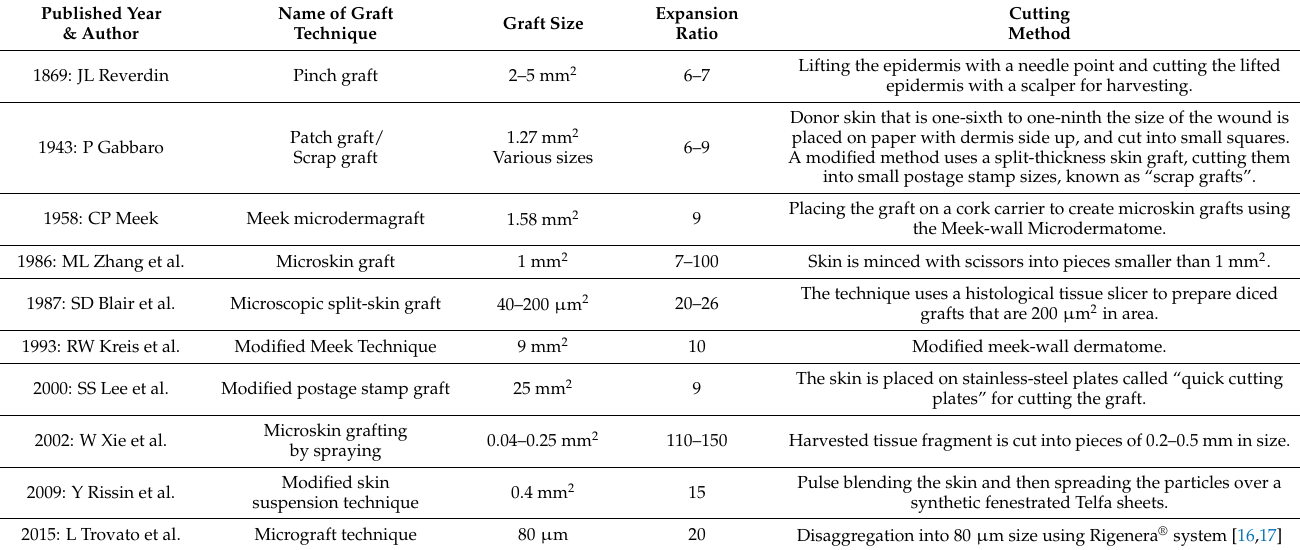
Table 1. Transition from skin grafting to micrograft